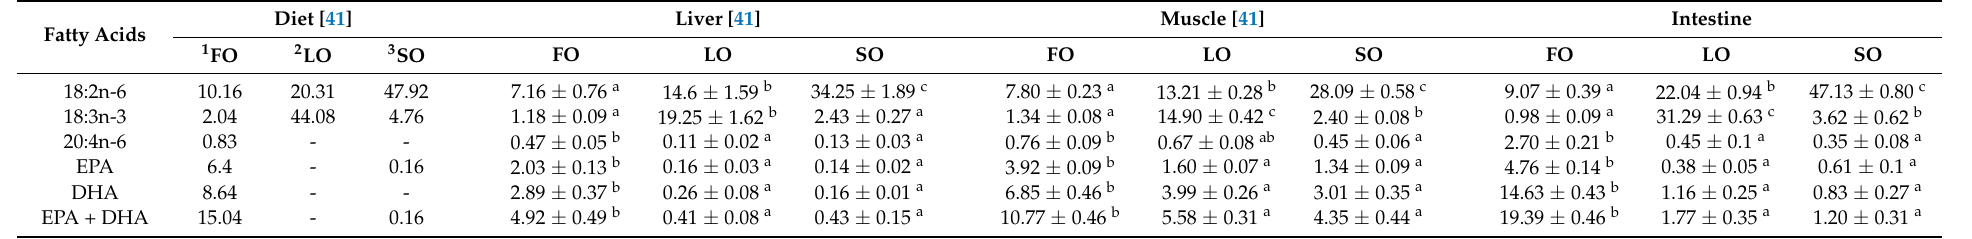
Table 1. The polyunsaturated fatty acid composition in diet, liver, muscle, and intestine of large yellow croaker (% total fatty acid methyl esters).